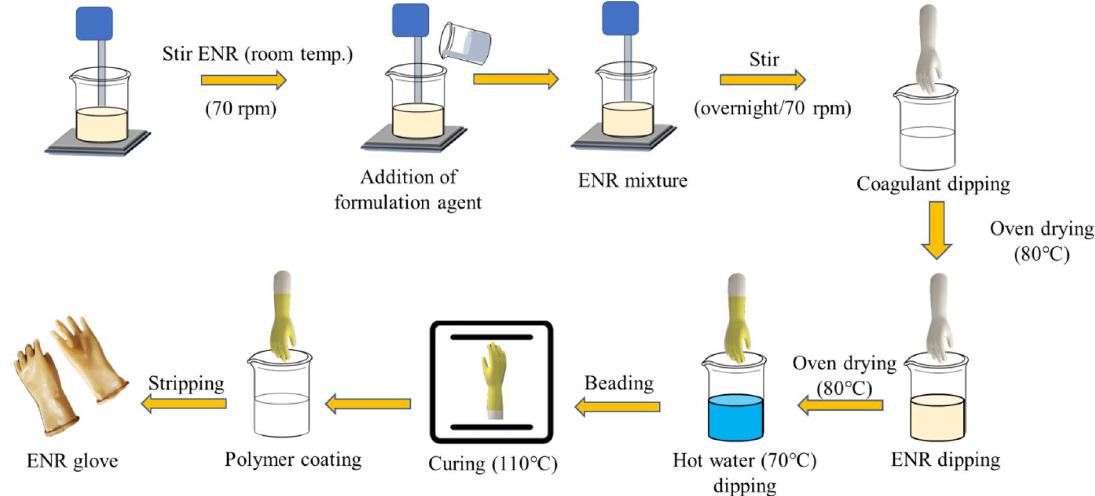
Figure 4. Fabrication process of SH glove using a ceramic hand